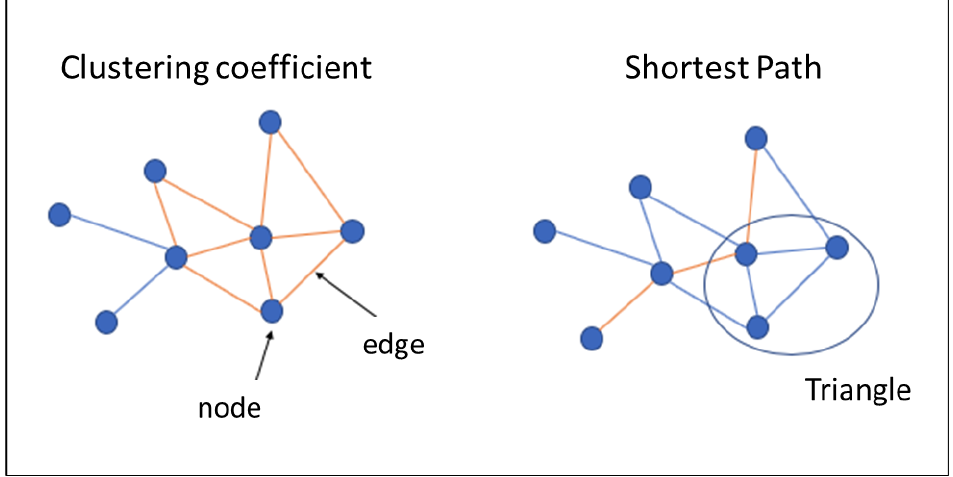
Figure 1. Example of indicators of complex